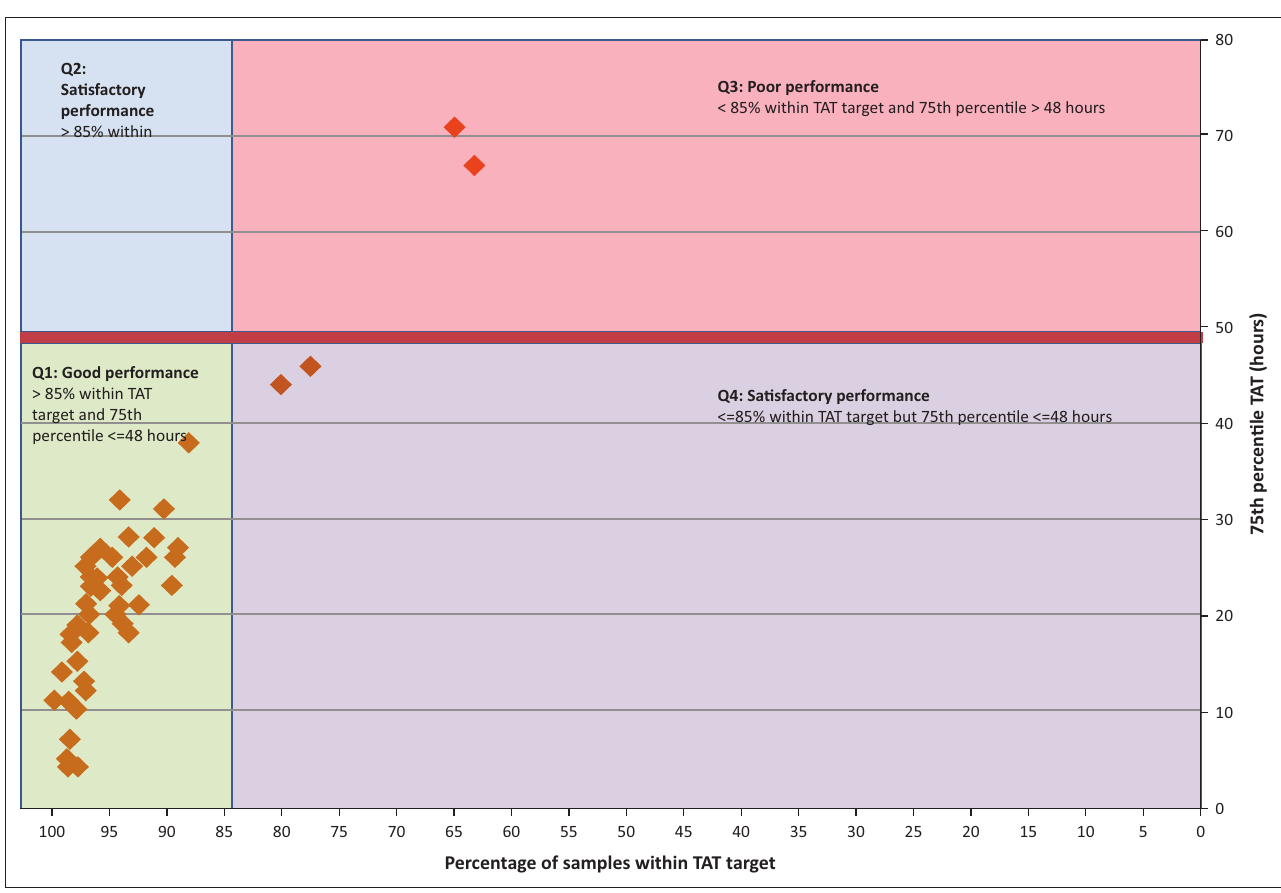
FIGURE 4: Scatter plot of CD4 laboratories reporting the percentage of samples within the TAT target (x-axis) and the 75th percentile (y-axis) with TAT performance categorised into four quadrants ( n = 52). Quadrant 1 (Q1, green) represents good performance with both > 85 % of samples within the TAT target and the 75th percentile < 48 h. Quadrant 2 (Q2, blue) identifies satisfactory performance with > 85 % of samples within the TAT target, but with a long tail at the 75th percentile (> 48 h). Quadrant 3 (Q3, red) reports poor performance where both the percentage of samples within the TAT target and the 75th percentile values are not meeting their targets. Quadrant 4 (Q4, purple) represents satisfactory laboratories with < 85 % of samples within the TAT target, but within the 75th percentile target of 48